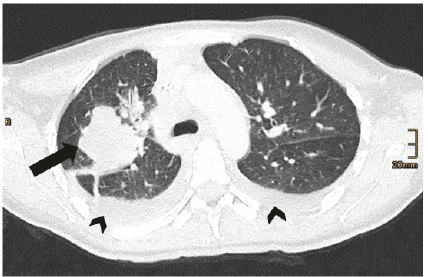
Figure 5: Chest computed tomography (CT) scan demonstrates a mass lesion (5 cm) in the right upper lobe of lung (arrow), and bilateral pleural effusions